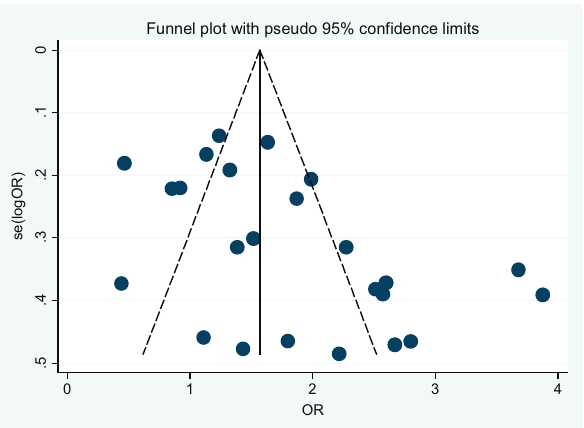
Figure 6: Begg ’ s funnel plot for evaluation publication bias in dominant gene